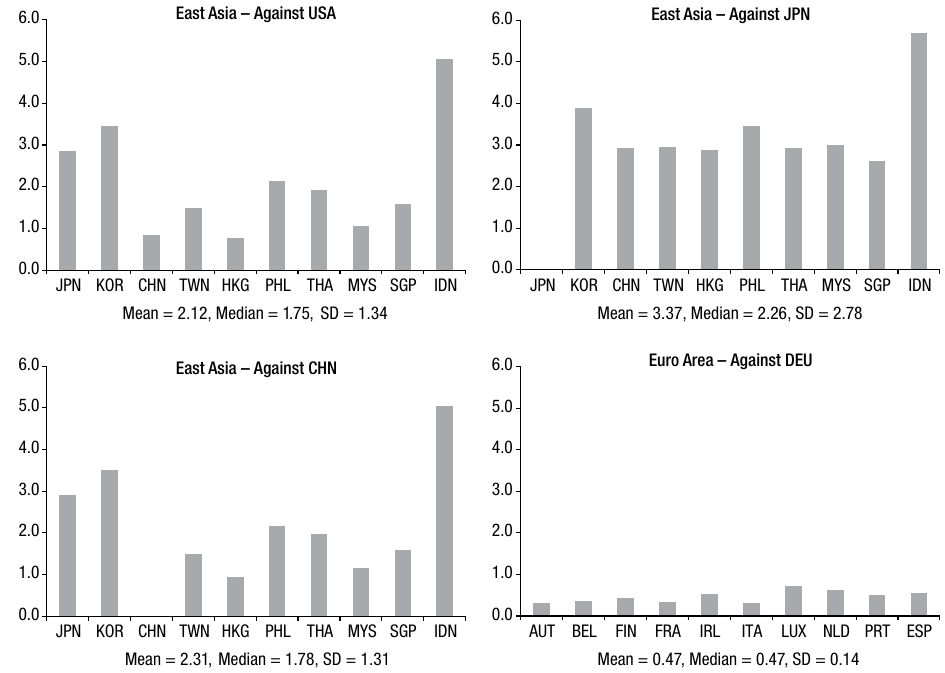
Fig. 4. Standard deviation of real bilateral exchange rate (×100), 1999:1–2009:12 Source : IMF: IFS; Taiwan National